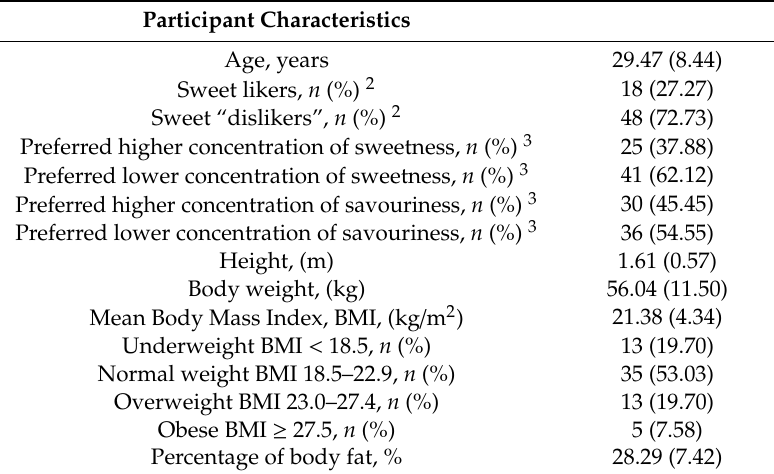
Table 1. General characteristics of female participants ( n = 66) 1 .